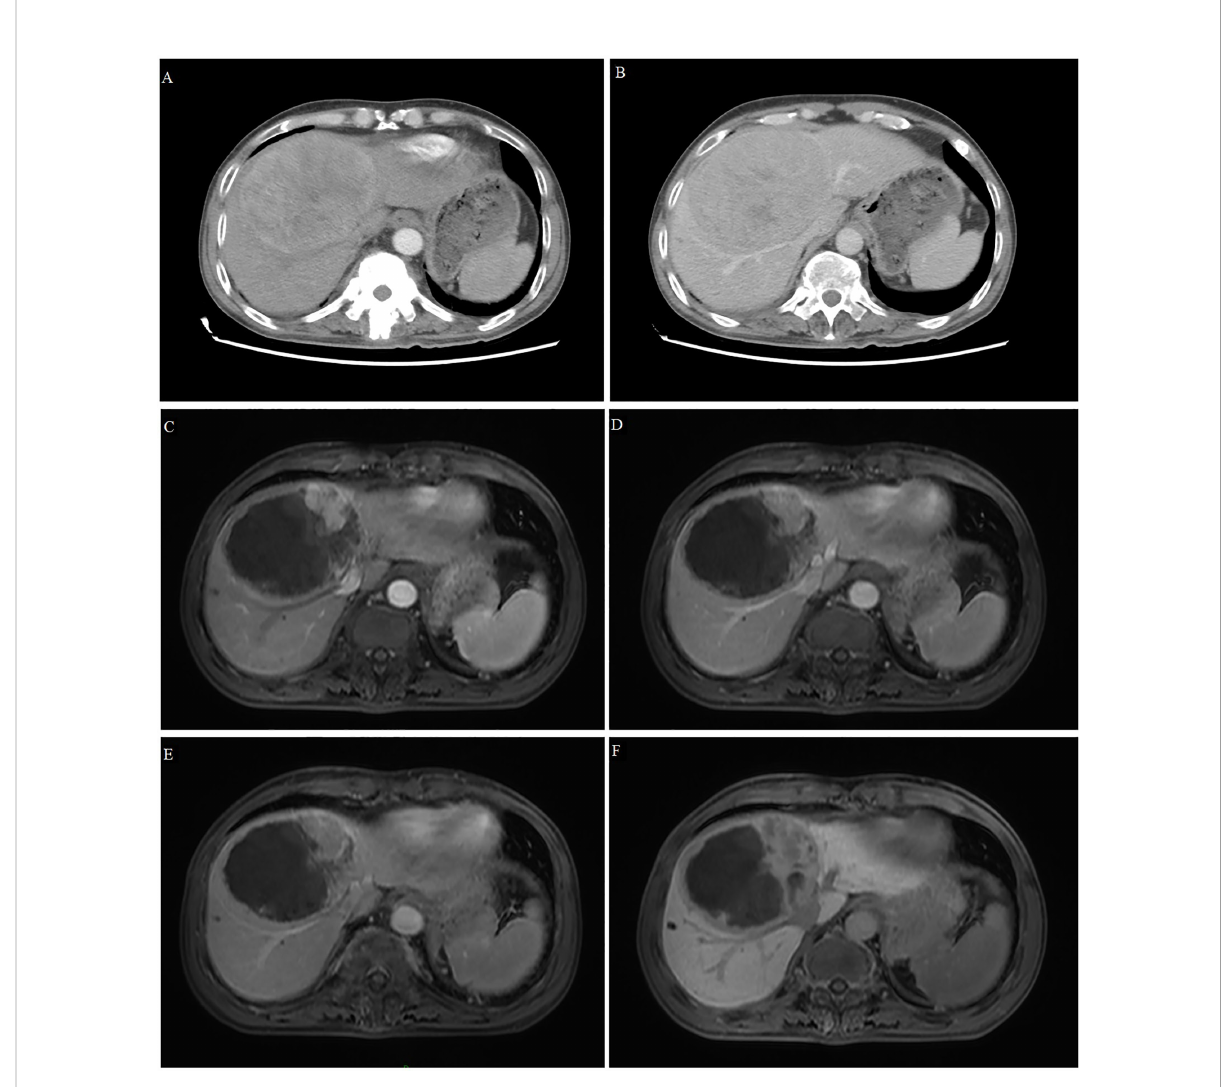
FIGURE 2 Computed tomography and magnetic resonance imaging of Case 2. (A, B) Tomography scans at admission showed a large, space-occupying lesion in the right liver, obvious inhomogeneous enhancement in the arterial phase (A) and relatively low density in the portal phase (B) . (C – F) T1-weighted magnetic resonance imaging after conversion therapy and before resection showed extensive tumor necrosis, but there was still a small active area around the tumor showing high signal intensity in the early arterial phase (C) and low signal intensity in the late arterial phase (D) , portal vein phase (E) and hepatobiliary phase (F)